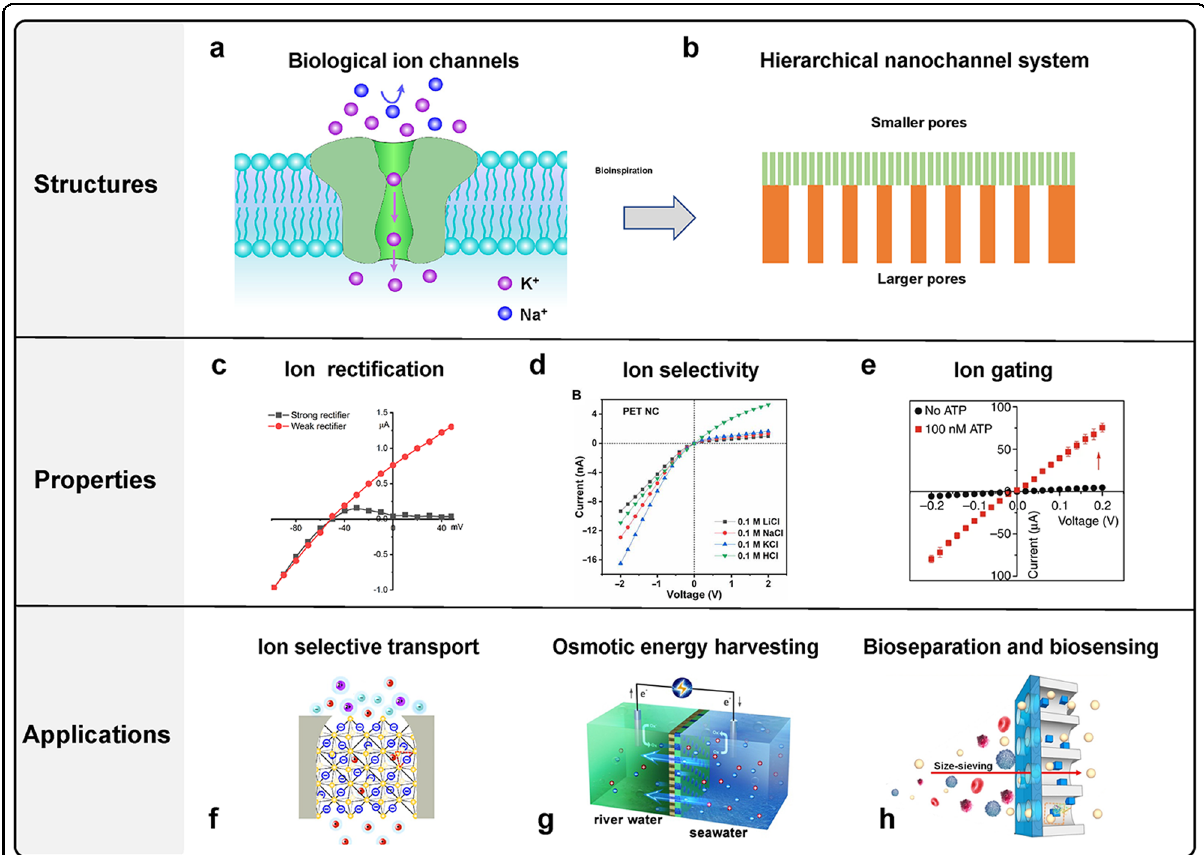
Fig. 1 Schematic illustrating bioinspired hierarchical nanochannel systems. a Schematic of a biological channel containing an ion conduction pore that enables rapid and selective ion transport. b Typical structure of a hierarchical nanochannel system. Ionic current ‒ voltage ( I ‒ V ) curves of arti fi cial ion nanochannels showing a strong rectifying effect ( c ) (Reproduced with permission 9 . Copyright 2001, Wiley-VCH), ion selectivity ( d ) (Reproduced with permission 10 . CC BY 4.0 (https://creativecommons.org/licenses/by-nc/4.0/)), ion gating ( e ) (Reproduced with permission 12 . CC BY (https://creativecommons.org/licenses/)). Hierarchical nanochannels show application prospects in ion-selective transport ( f ) (Reproduced with permission 98 . Copyright 2021, American Chemical Society), osmotic energy harvesting ( g ) (Reproduced with permission 25 . Copyright 2017, American Chemical Society.), bioseparation and biosensing ( h ) (Reproduced with permission 88 . Copyright 2020,